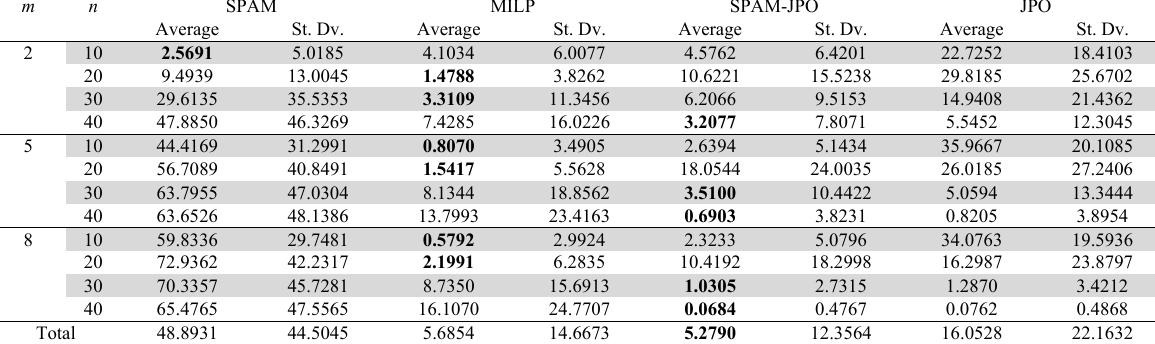
Large-sized test instances: RDI values for m and n (part 2)